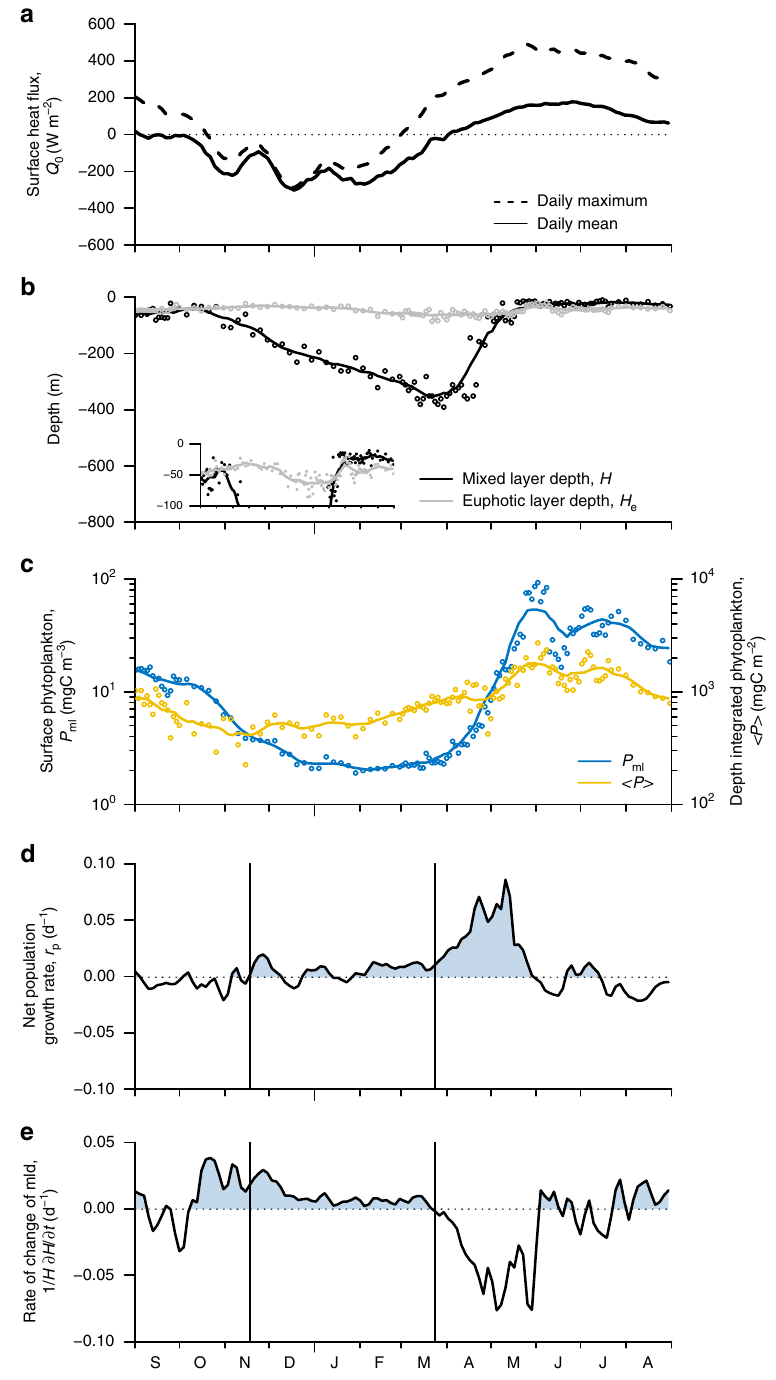
Fig. 2 Time series of key variables measured or derived from fl oat 6901516 from September 2013 to July 2014. a Daily average surface heat fl ux (black continuous lines) and the maximum surface heat fl ux at 15 h GMT, close to the local noon (black dashed lines). b Mixed layer ( H , black circles) and euphotic layer depths ( H e , gray circles). A zoomed view of H and H e for depths shallower than 100 m is included as an inset. c Mixed layer averaged phytoplankton carbon biomass concentration ( P ml , blue circles), and depth-integrated phytoplankton carbon biomass ( h P i , yellow circles). The continuous lines in panels a – c represent 24-day running averages that remove short-term fl uctuations. d Net population growth rate, r p . e Rate of change of mixed layer depth, 1 H ∂ H ∂ t , computed from the 24-day average mixed layer depth. The fi rst vertical line marks the initiation of the weak winter accumulation phase, computed as the time when r p becomes positive for at least 24 days. The second vertical line marks the initiation of the spring bloom, computed as the time when 1 H ∂ H ∂ t becomes negative for at least 24